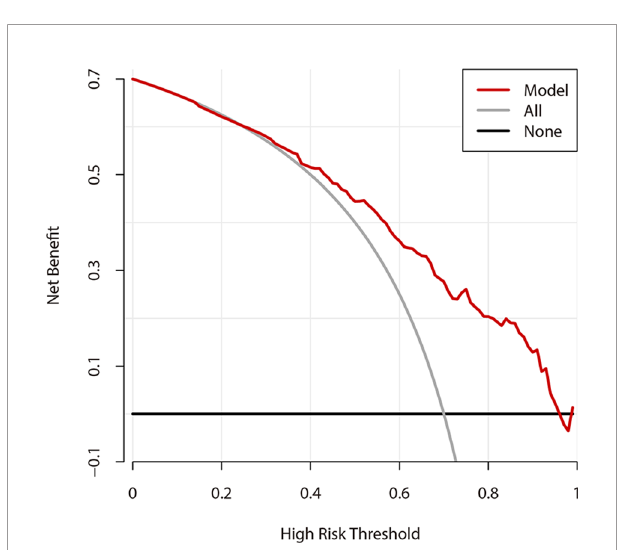
FIGURE 6 | Decision curve analysis of prediction model.